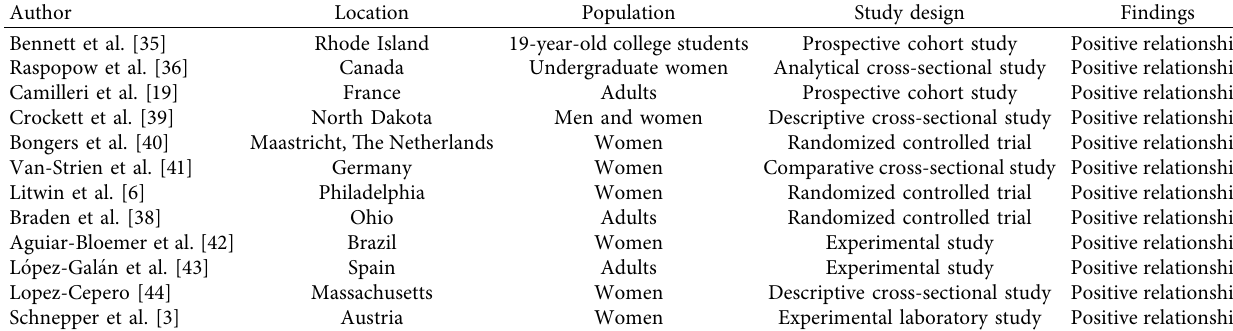
Table 1: Studies that report a relationship between negative emotions and hyperpalatable energy-dense food intake in adults.